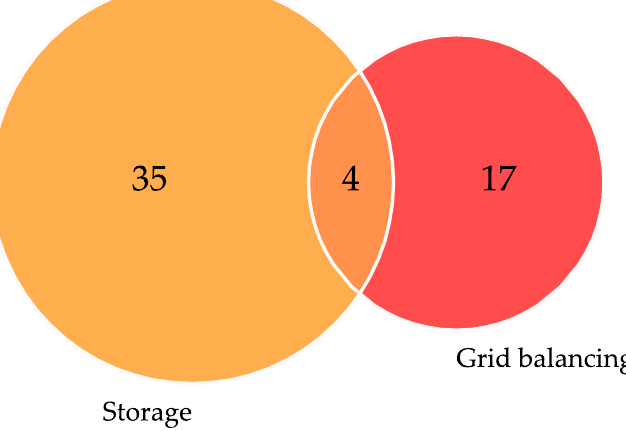
Figure 7. Number of projects per aim of the